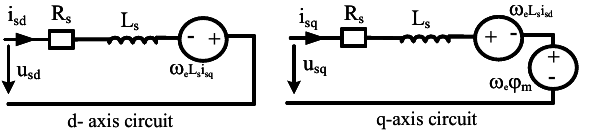
Figure 12: System under study.